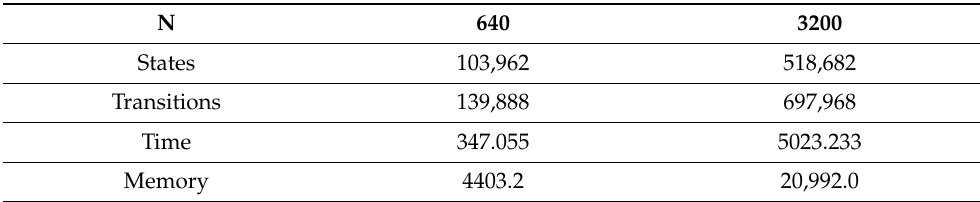
Table 4. Model information of MDP in PAT.